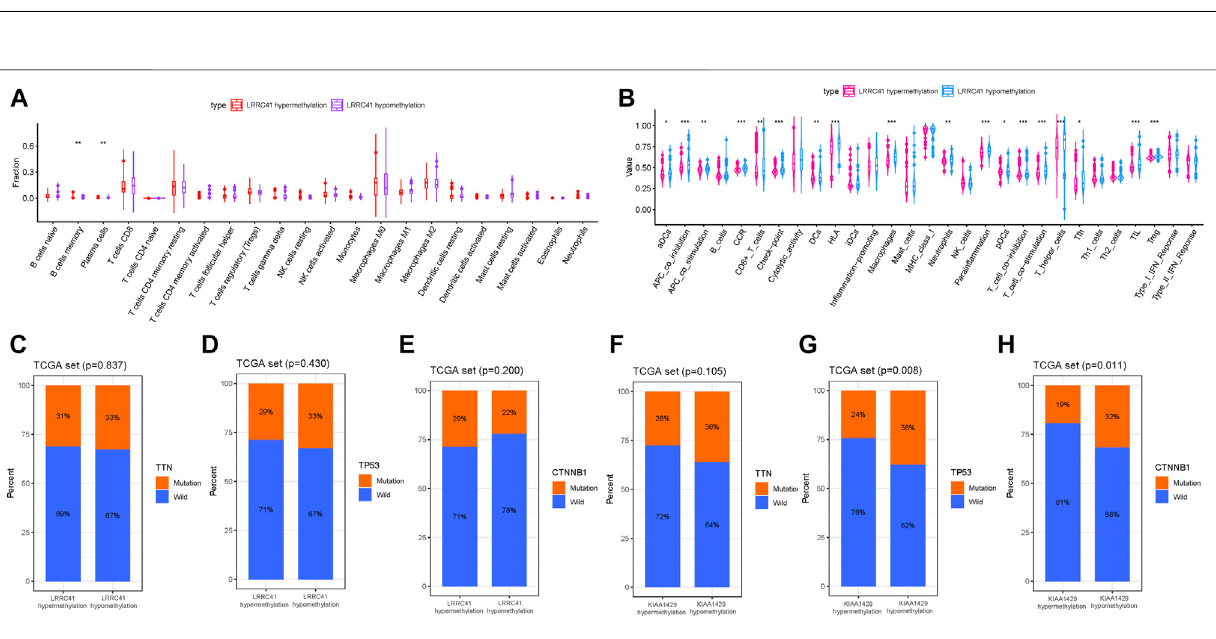
Frontiers in Molecular Biosciences |